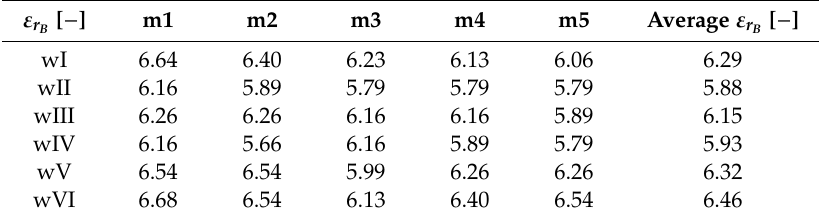
Table 5. Dielectric constants calculated based on propagation time through the slabs (‘B’ method).